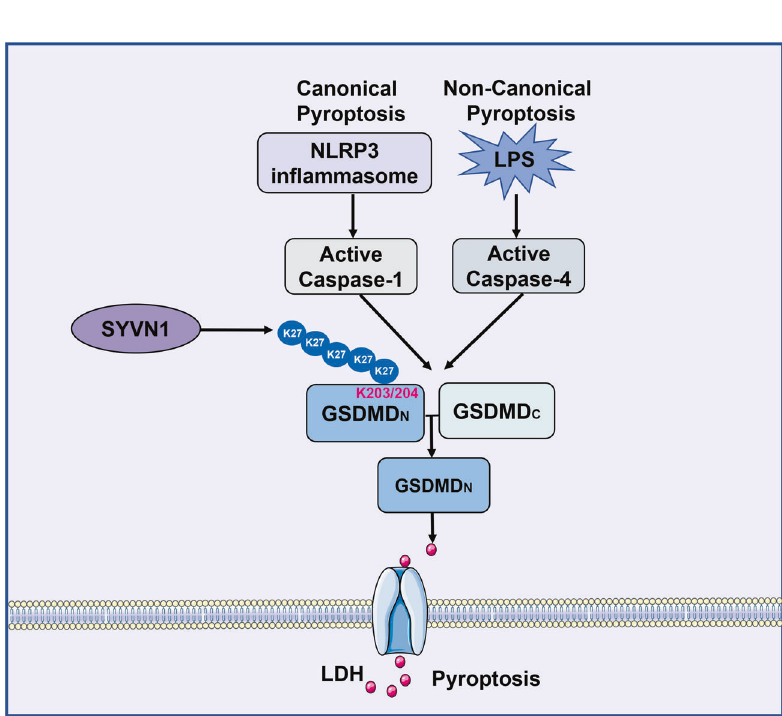
Fig. 7 SYVN1 polyubiquitinates K203 and K204 residues of GSDMD. A Coomassie blue-stained bands of polyubiquitinated GSDMD. HEK293T cells were co-transfected with Flag-GSDMD, Myc-SYVN1 or Myc-SYVN1-C329S, and HA-ubiquitin (shown above the lanes). The square areas indicate regions from which proteins were removed for MS. B , C LDH assay of HEK293T cells transfected with pCMV-Myc- Caspase-1/4 (300 ng), p3 × Flag-hGSDMD-FL (600 ng), or GSDMD mutants (600 ng). The analysis was performed 24 h after transfection. D LDH